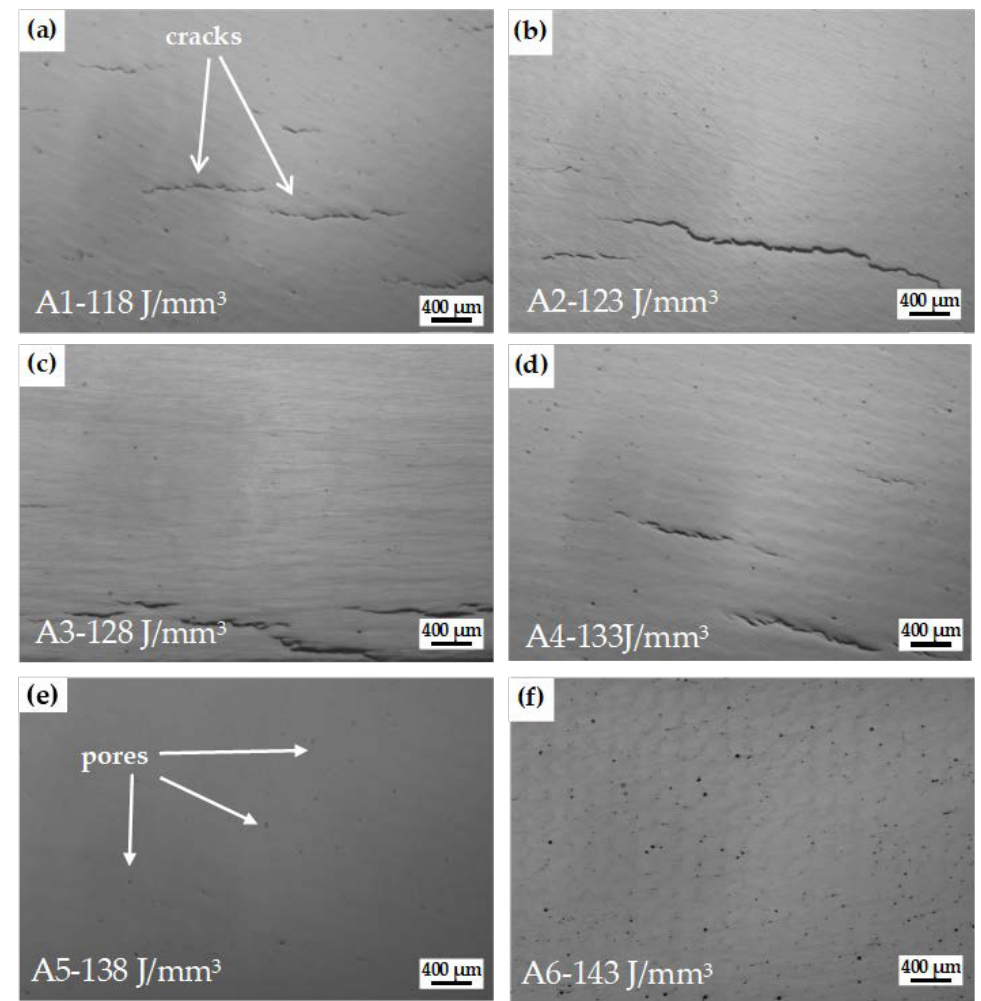
Figure 5. Metallographic photographs of samples formed with different volume energy densities: